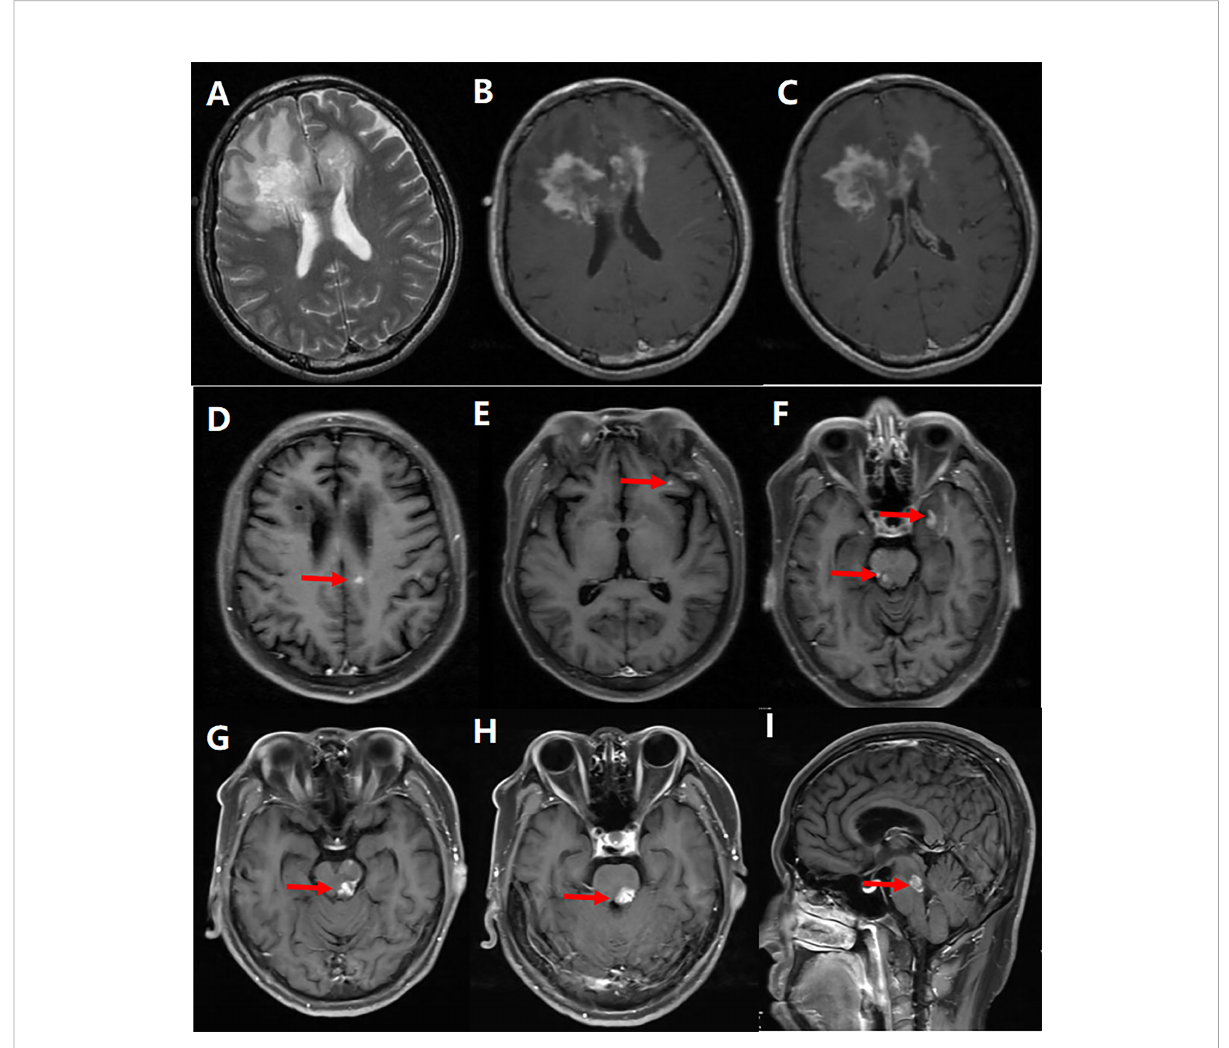
FIGURE 3 Representative example of tumefactive multiple sclerosis (MS). A 44-year-old man ’ s MRI scan at the fi rst attack revealed an extensive hyperintensity on T 2 -weighted (A) and contrast-enhanced T 1 -weighted (B, C) images extending from the left frontal lobe through the corpus callosum knee to the left frontal lobe, and the lesions on the contrast enhancement images gradually disappeared after treatment; 7 months after the onset, some small patchy lesions developed in the right lateral paraventricular (D) , frontal (E) , temporal, and left midbrain (F) , which gradually disappeared after treatment; The second relapse occurred 19 months after the fi rst episode, and the patient ’ s brainstem developed a new patchy lesions (G – I)